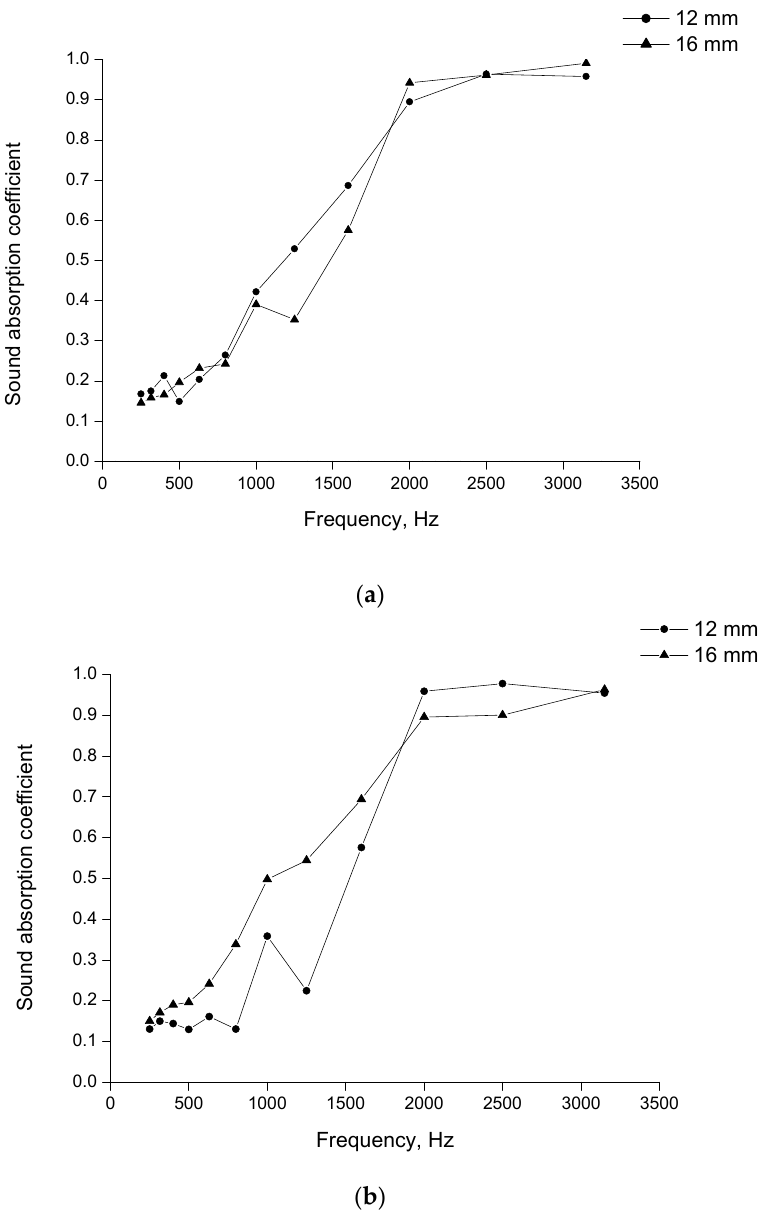
Figure 8. Sound absorption coefficient for tufted fabric made from ring spun yarn; ( a ) cut pile; ( b ) loop pile.